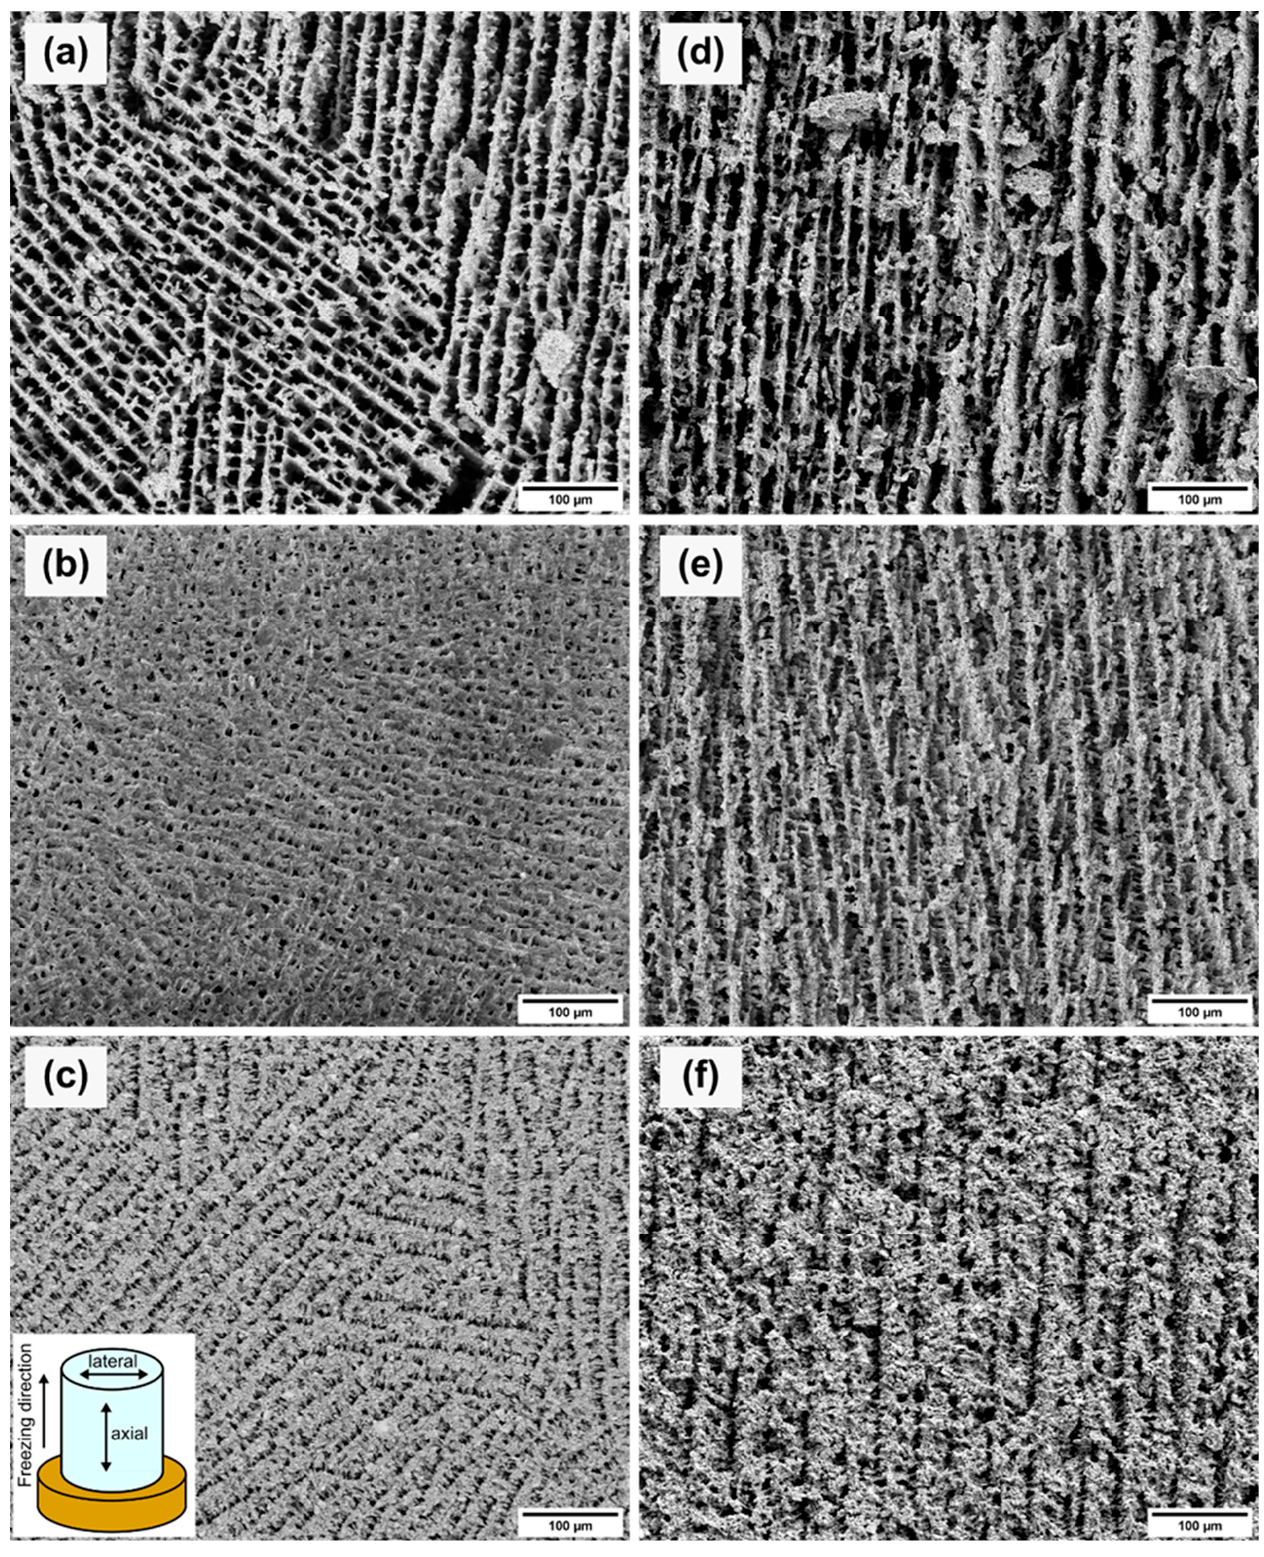
Figure 5. SEM images of the lateral (left) and axial (right) cross-sections of samples 10Y ( a , d ), 15Y ( b , e ), and 20Y ( c , f ). The axial cross-sections planes contain the direction of the unidirectional solidification.